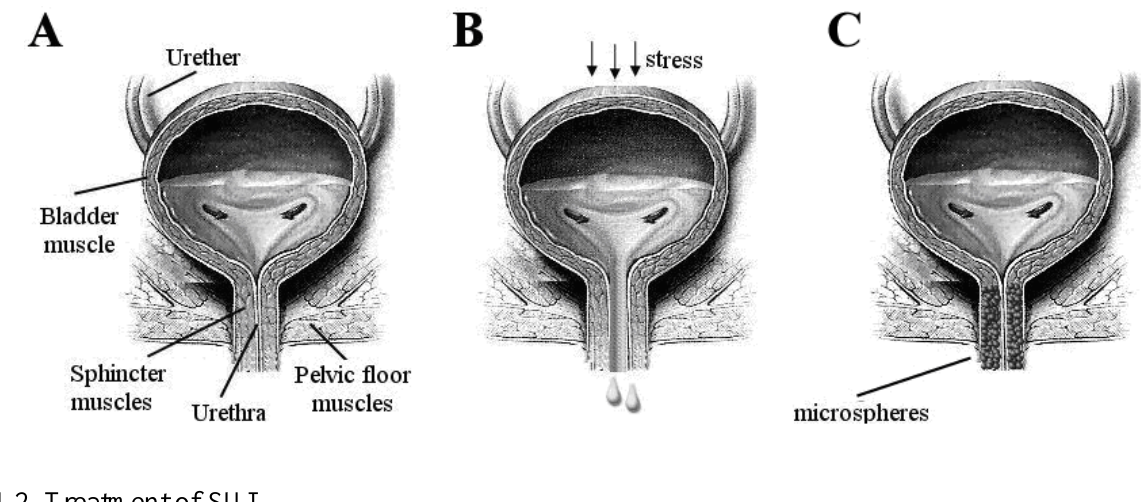
Figure 3 . Front view of bladder. a) Strong sphincter and pelvic muscles keep the urethra closed. b) Weak muscles result in urine leakage. c) Complete coaptation of the urethra, which is achieved by injection of the bulking agent around the